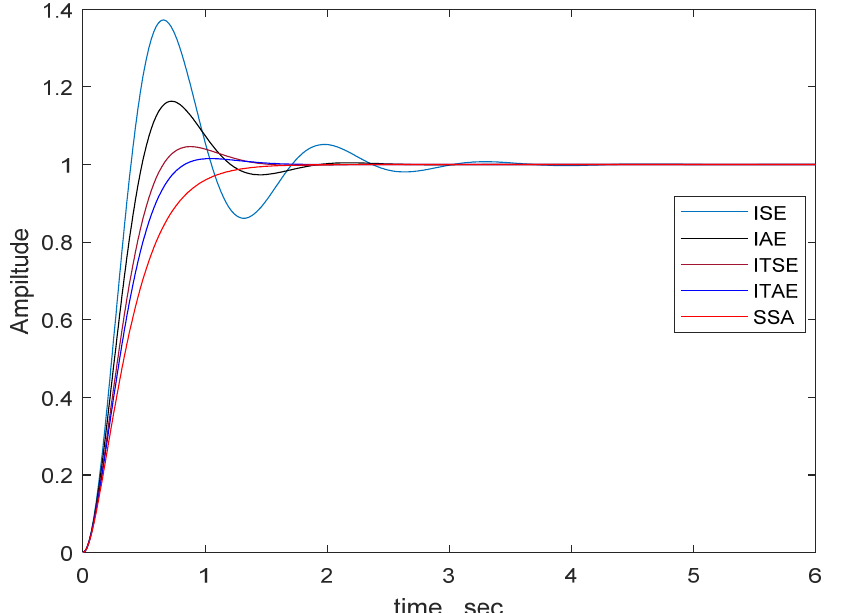
Figure 15. A comparison between unit-step response with four criteria and the proposed method.